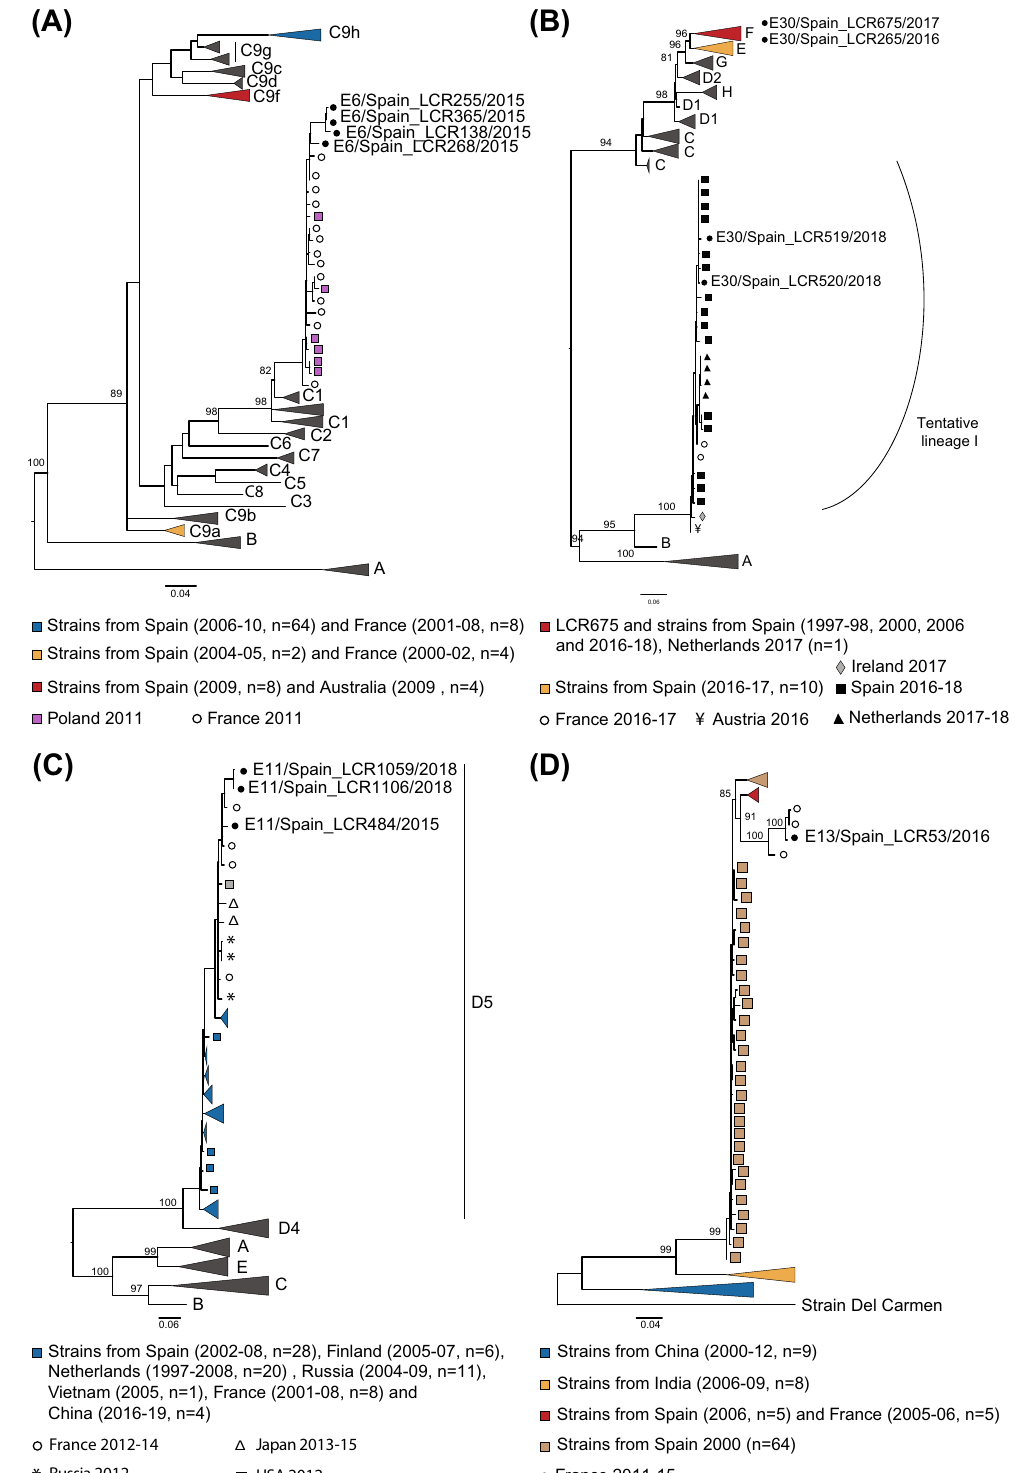
Figure 1. Maximum-likelihood trees based on a partial VP1 inferred by IQ-TREE v.2.0.6 for the four genotypes study here: E6 ( A ), E30 ( B ), E11 ( C ) and E13 ( D ). Sequences reported in our study are indicated by black circles. Numbers on nodes indicate the bootstrap support of the node (> 80) and the scale bars represents the expected number of nucleotide substitutions per site. Non collapsed trees can be found in Supplementary Fig. 4A–D. Trees are annotated with the classification proposed by Smura et al. and Cabrerizo et al. 10,19 for E6, the classification proposed by Bailly et al. 20 for E30, and the classification proposed by Li et al. 22 for E11. Only bootstrap values above 80% are indicated in branch nodes. Scale bars indicate nucleotide substitutions per